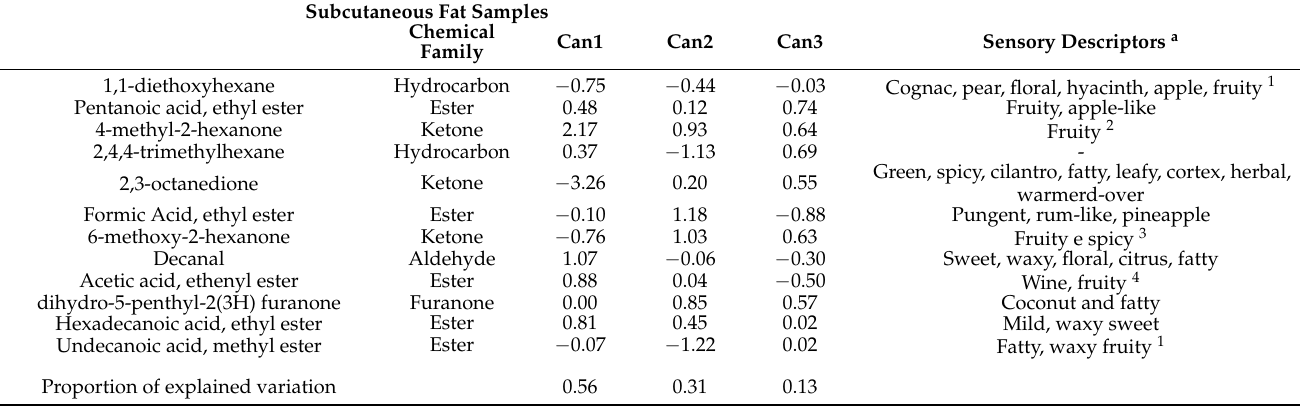
Table 5. Volatile compounds of subcutaneous fat of Toscano dry-cured ham selected by stepwise discriminant analysis. Canonical discriminant analysis scores (Can1, Can2, and Can3) were used to separate hams belonging to different seasoning lengths (S12, S14, S16, S18).